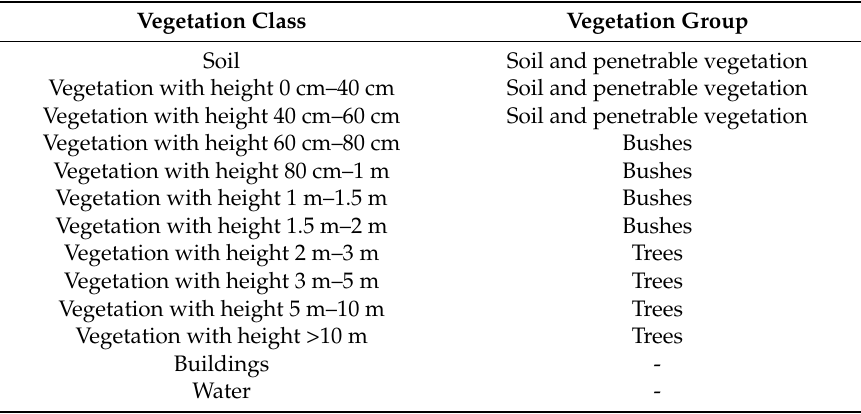
Table 3. Representative classes of LiDAR vegetation in